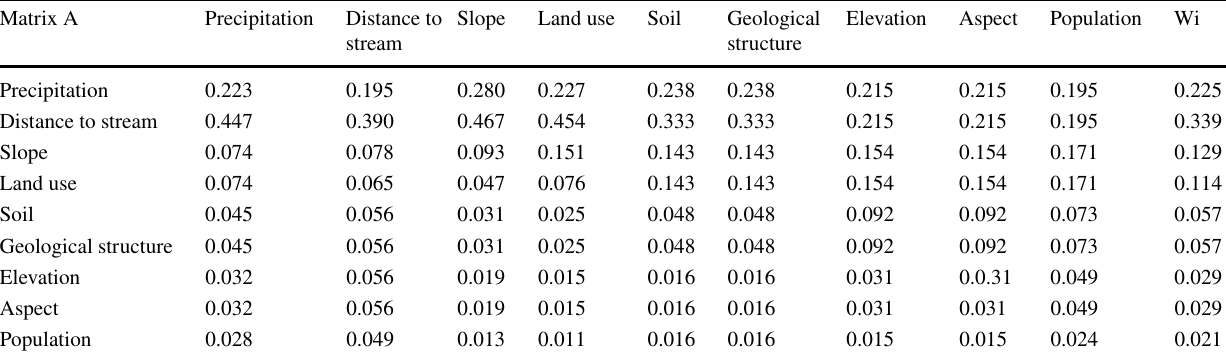
Table 5 Determination of weight vector from the normalization matrix Matrix